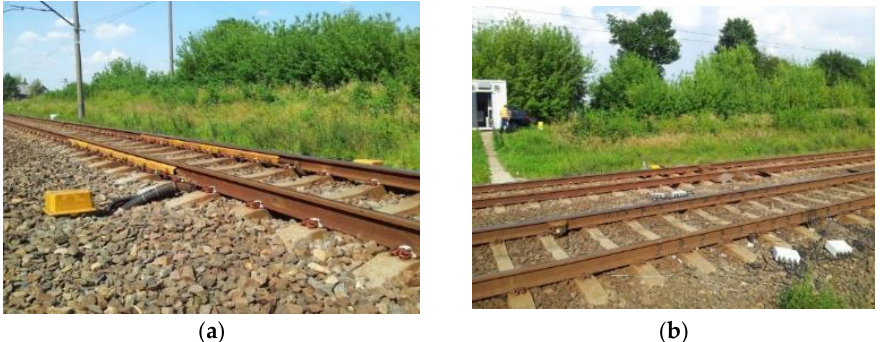
Figure 6. Used measurement systems: ( a ) regular system ATLAS ‐ LG; ( b ) specially designed system IC VEIP.